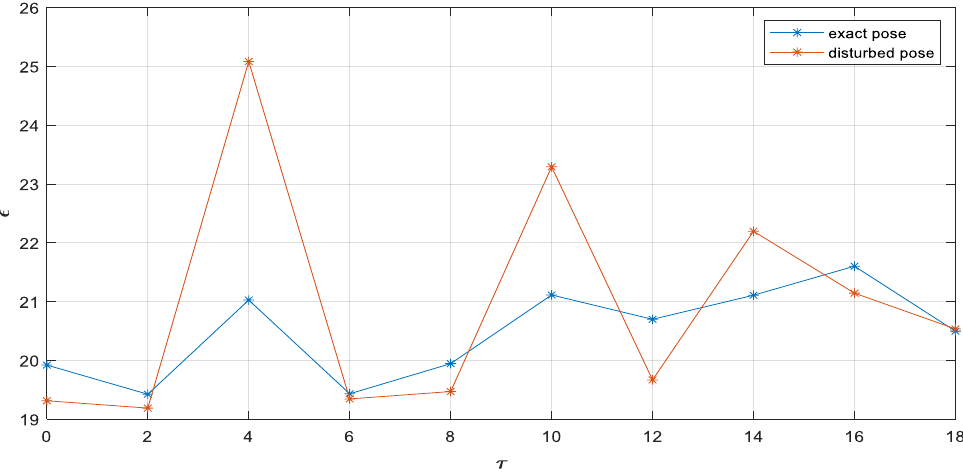
Figure 20. Mean square error performance 𝜖 in pixels with added uncertainties in cameras’ poses.